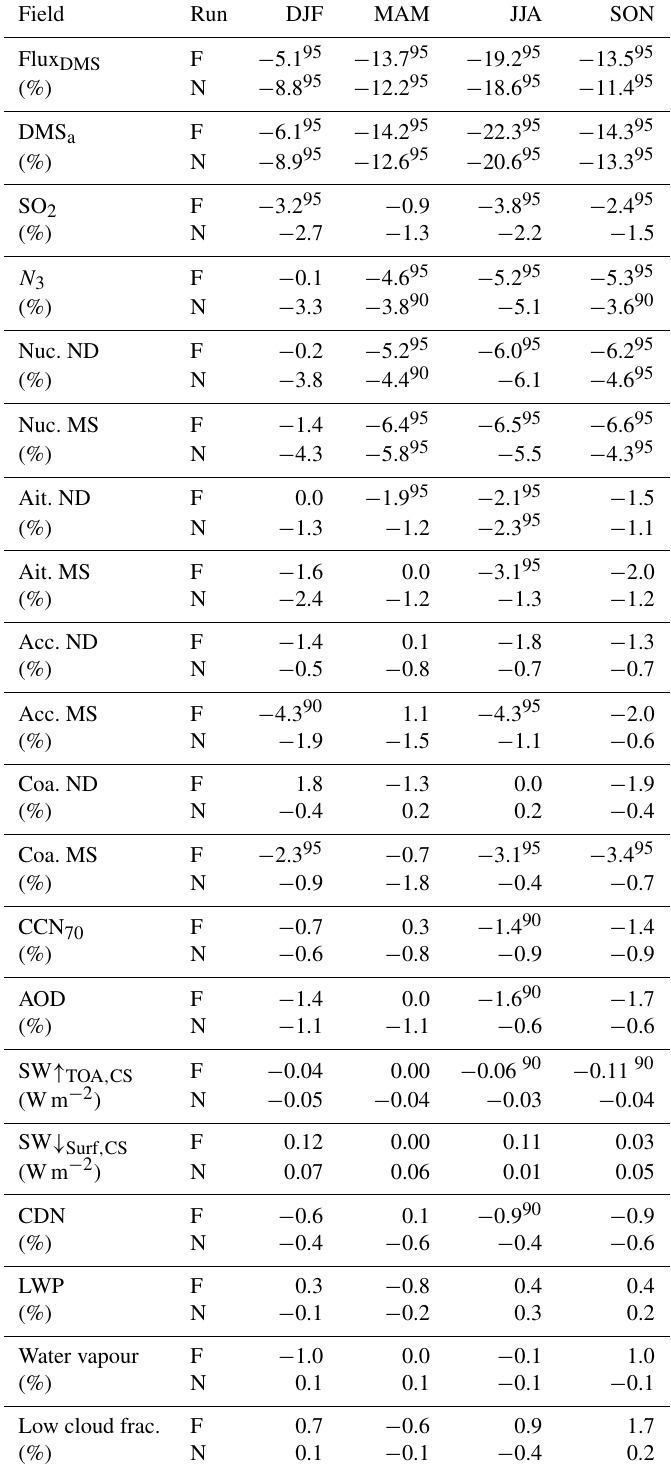
Table 3. Seasonal changes over the Maritime Continent–Australian region as a percent (except for SW ↓ Surf , CS , SW ↑ TOA , CS and SW ↓ Surf which are an absolute change in Wm − 2 and w in cms − 1 ) for both the free-running ensemble (F) and the nudged simulations (N). Number density is abbreviated to ND and mass to MS for each of the four aerosol modes (nucleation, Aitken, accumulation and